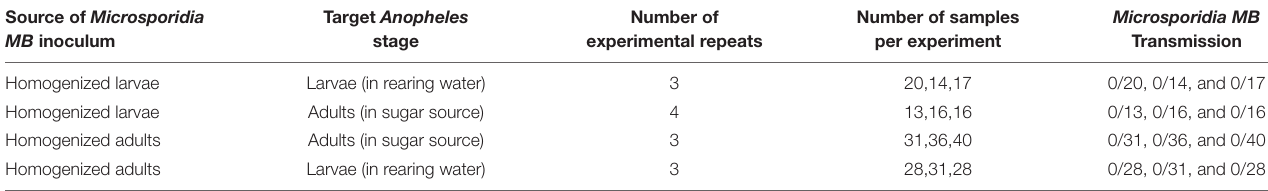
TABLE 2 | Homogenates from larval and adult Microsporidia MB infected mosquitoes are not able to establish infections after being ingested by An. arabiensis